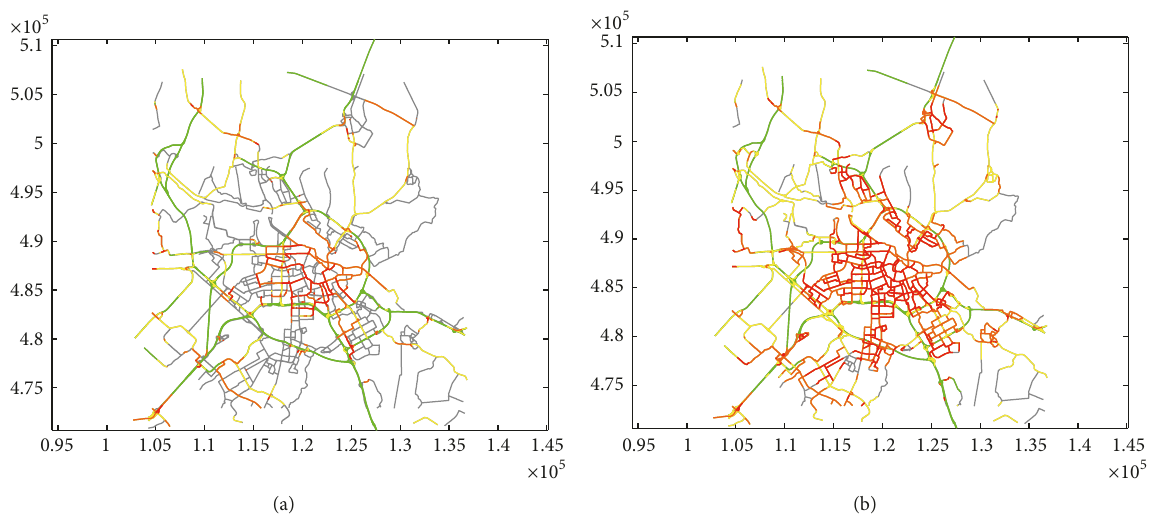
Figure 2: Modelled network of the region of Amsterdam, before (a) and after (b) gap filling. The colours indicate the average speed: green > 80 km/h, yellow 50–80 km/h, orange 30–50 km/h, and red 0–30 km/h. For the grey links, no speed data could be